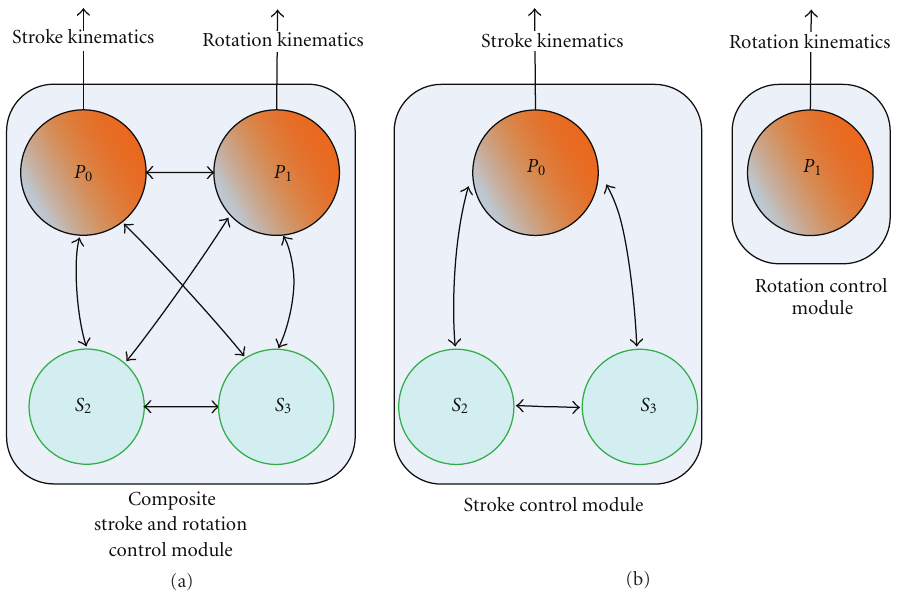
Figure 21: The qualitative functional decomposition derived for the evolved autonomous altitude gain controllers and steer controllers. Most of the steer controller’s wing kinematics can be decomposed with a typical CPG-like functional template shown in (a) as a closely coupled stroke and rotation oscillators with steady beat rate and steady amplitude. Most of the altitude gain controllers can be decomposed with the functional template shown in (b), with a dedicated stroke oscillator along with a saturated rotation control module.